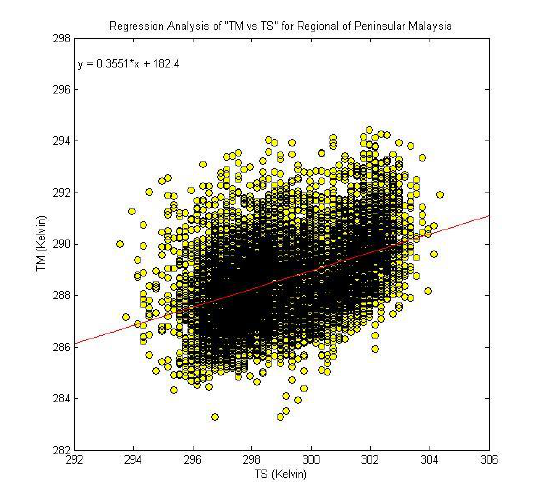
Figure 4. Regional T M model is developed by combining all the radiosonde stations over Peninsular Malaysia to form a single equation of linear regression analysis.